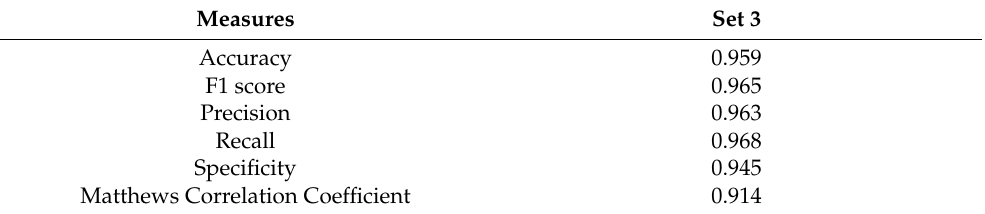
Table 11. Effectivity of the CNN model for recognition of trolls.